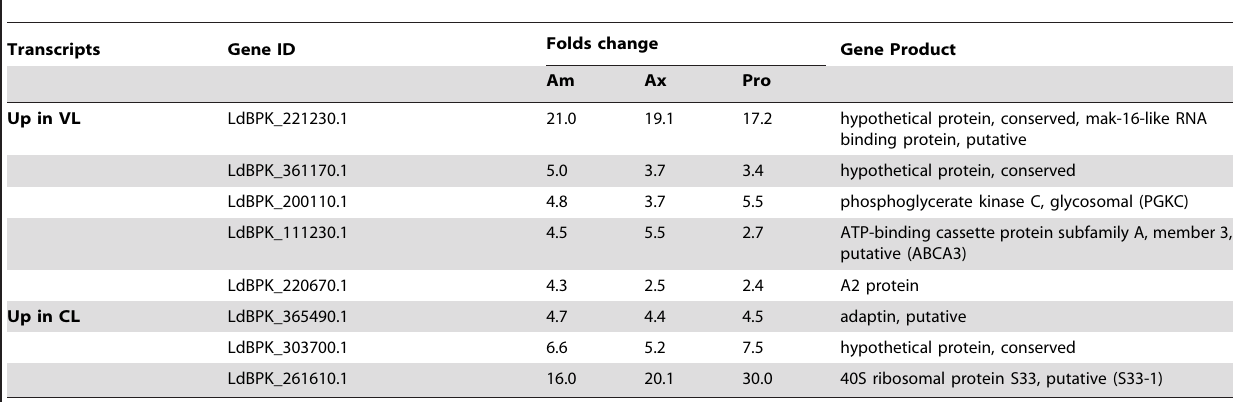
Table 4. Genes with more than 4 fold change in transcript levels between the CL-SL and VL-SL isolates.